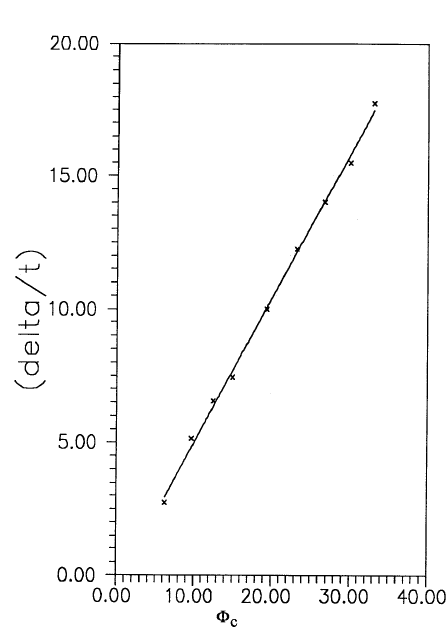
Fig. 12. Variation of deflection – thickness ratio as a function of dimensionless parameter Φ c .